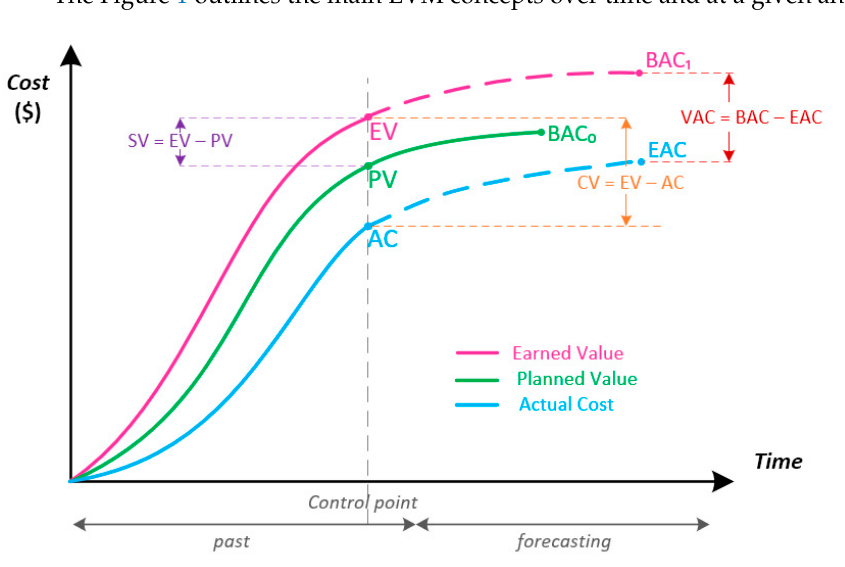
Figure 1. Key metrics of the EVM technique [31].